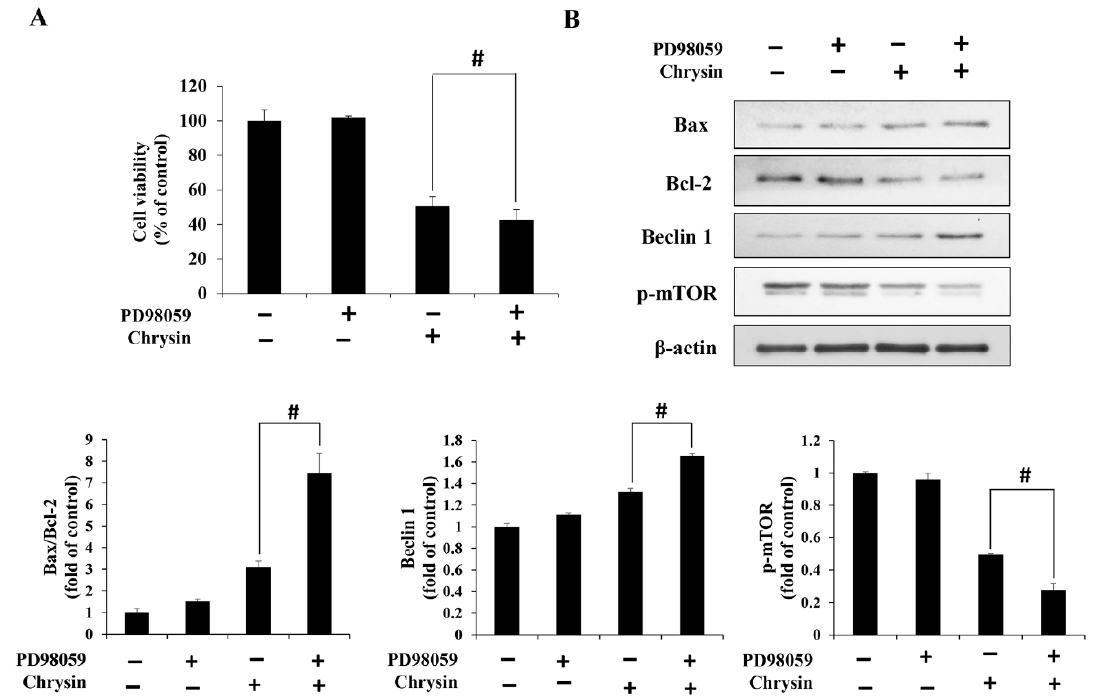
Figure 6. Chrysin induces autophagy through the ERK/mTOR pathway in MC-3 oral cancer cells. ( A ) The viability of cells pre-treated with PD98059 (an ERK inhibitor) and subsequently treated with chrysin. ( B ) The levels of the apoptosis- and autophagy-related proteins Bax, Bcl-2, Beclin-1, and p-mTOR. Quantification was performed using Image J. The results are presented as the means and standard deviation of three independent samples. The statistical differences were determined by the Dunnett’s t -test: # p < 0.05, compared with the chrysin treatment group.